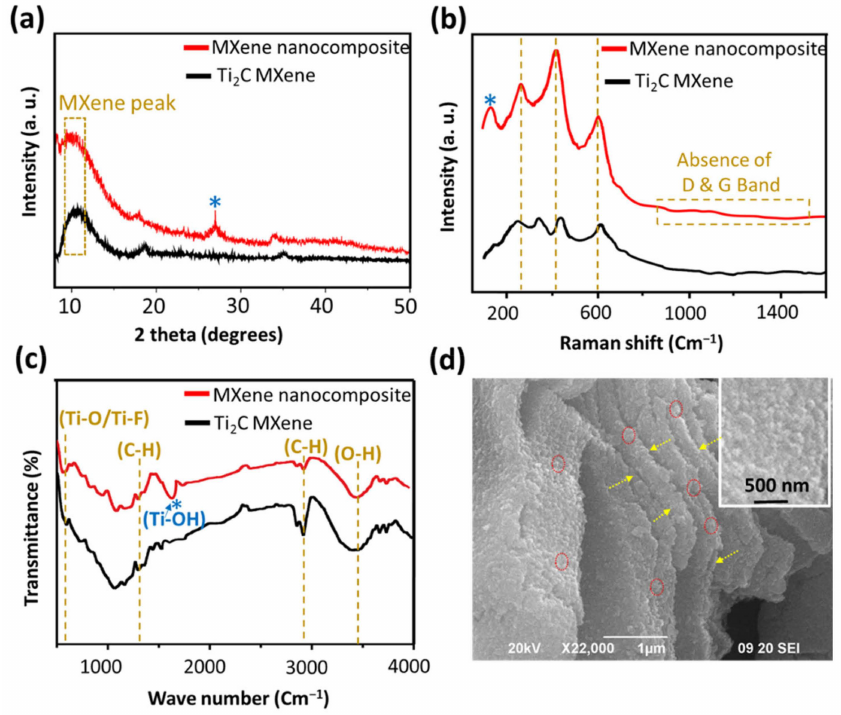
Figure 2. Characterization of Ti 2 C MXene and Ti 2 C-TiO 2 MXene nanocomposite (synthesized by controlled oxidation of MXene nanosheets using 10% H 2 O 2 for 15 min of reaction), ( a ) XRD patterns, ( b ) Raman spectra, ( c ) FTIR and ( d ) SEM image of a typical nanocomposite (inset showing in-situ synthesized TiO 2 nanoparticles from Ti 2 C MXene), arrows show the sheets while circles indicate the position of TiO 2